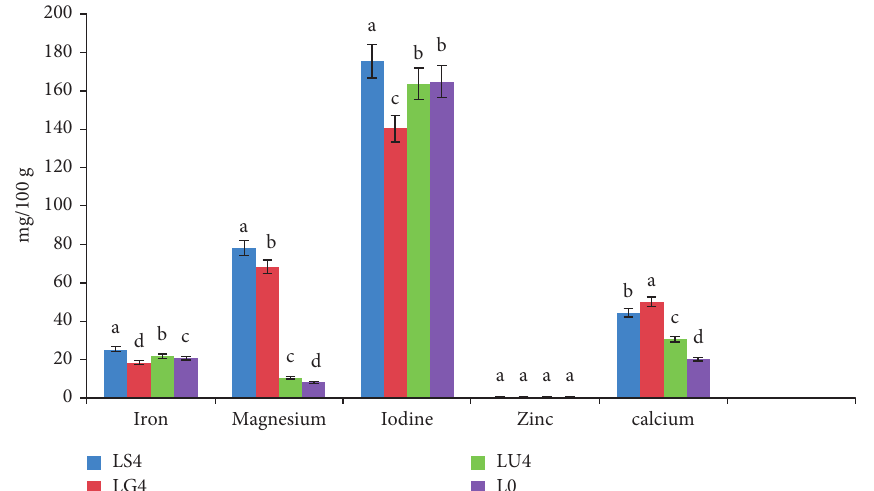
Figure 7: Mineral content of fruit paste with 3% algae powder. Different letters indicate significant differences ( p < 0 . 05 ) .